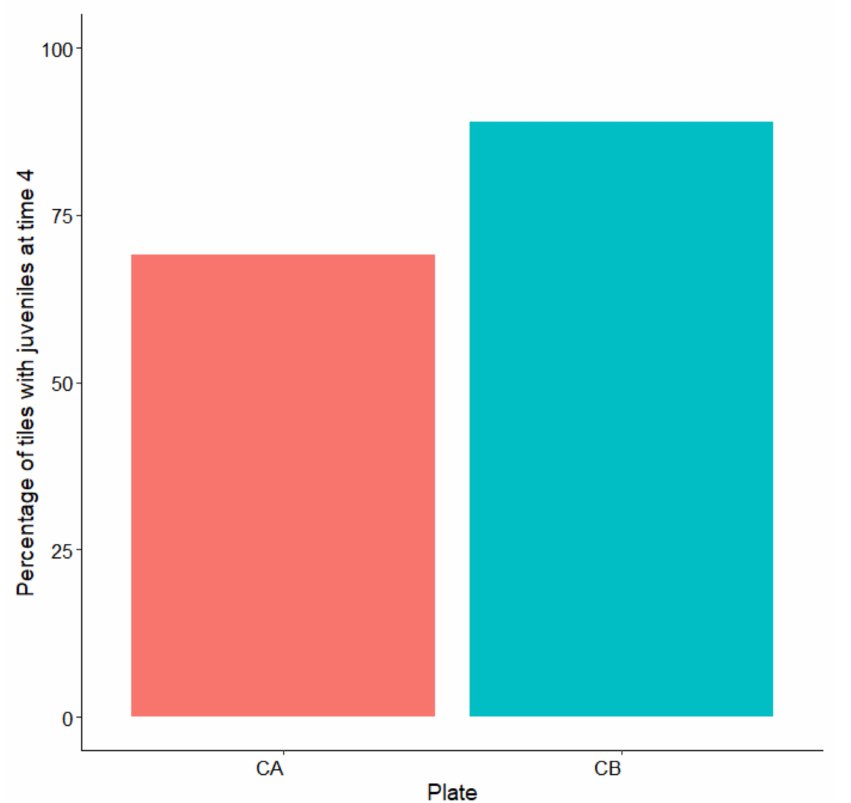
Figure 7. Percentage of tiles with juveniles after four months (Time 4) on the two plates (CA and